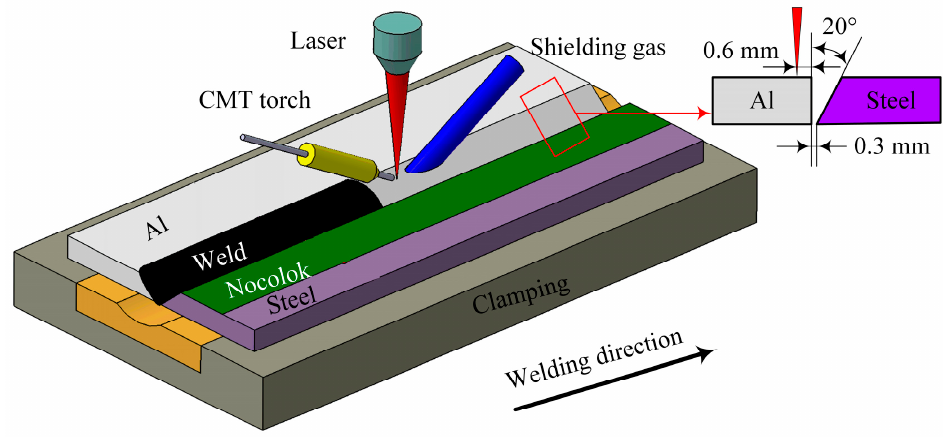
Figure 1. Schematic diagram for experimental set-up and groove geometry of the specimens. CMT: cold metal transfer.